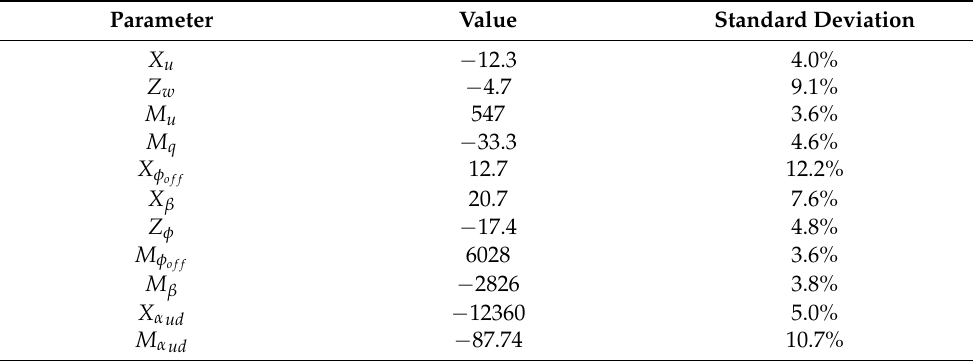
Table 2. This indicates the estimated stability and control derivatives [143].